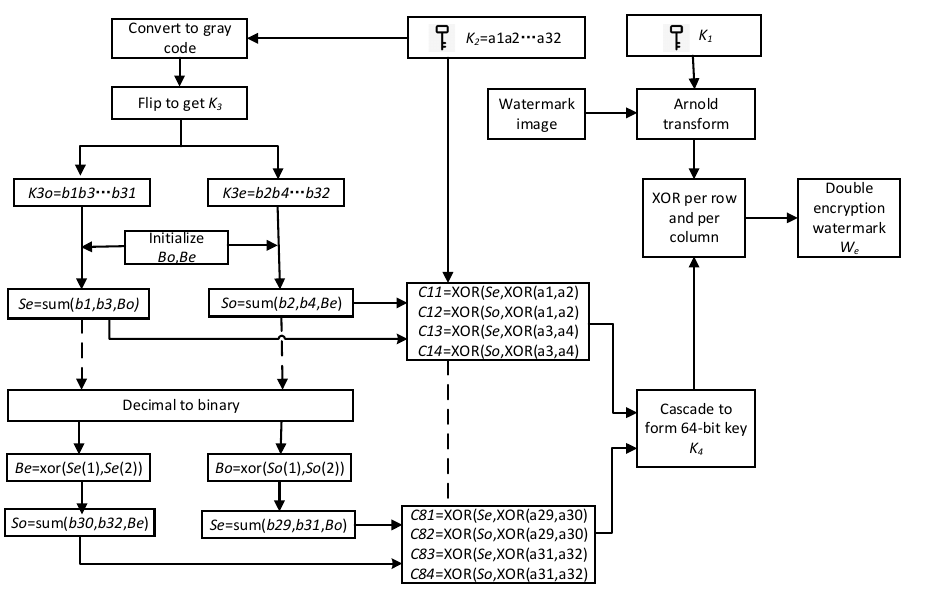
Figure 2. Watermark information encryption flow chart. Algorithm 1: Two-Level Encryption Algorithm Algorithm 2: Robust Watermark Embedding